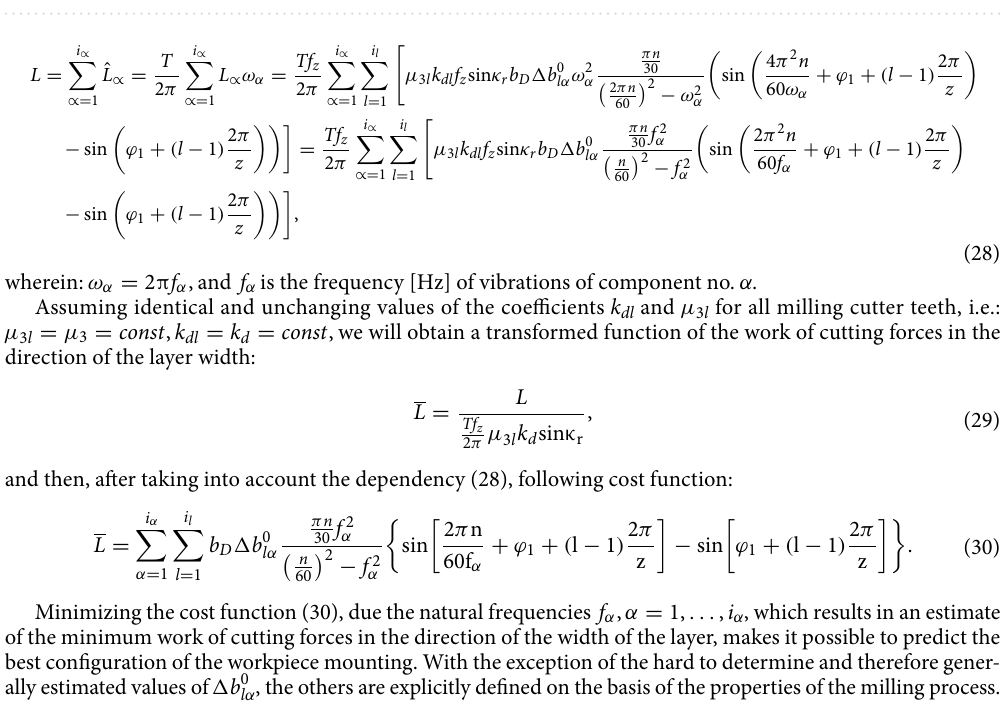
Figure 3. Research object: ( a ) workpiece assembly, ( b ) simplified scheme, accelerometers and fastening screws positions are